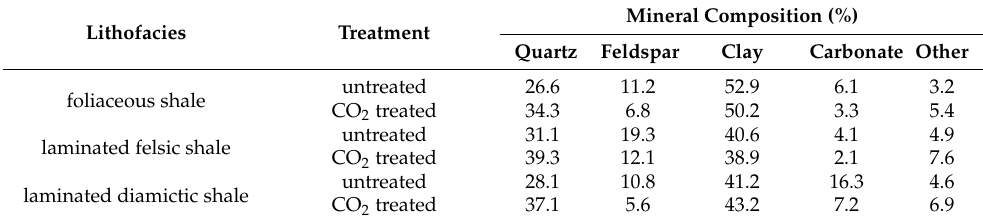
Table 2. Mineral composition analysis of shale samples.